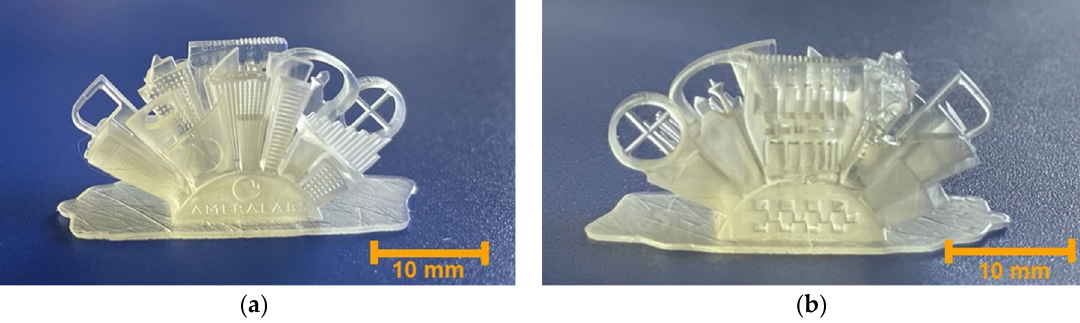
Figure 7. Images of SLA 3D printed polymer structures. The front side is on the left ( a ), and the back side is on the right ( b ).